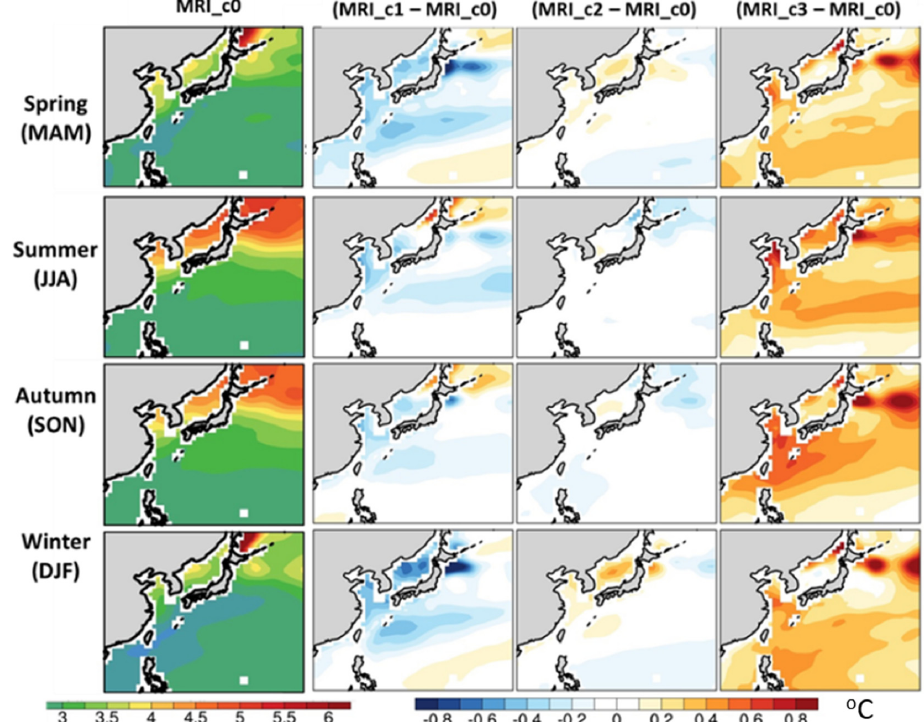
Figure 1. The average sea surface temperatures (SSTs) in di ff erent seasons under the c0 scenario and di ff erences between other scenarios and c0. MAM: March, April, and May; JJA: June, July, and August; SON: September, October, and November; DJF: December, January, and